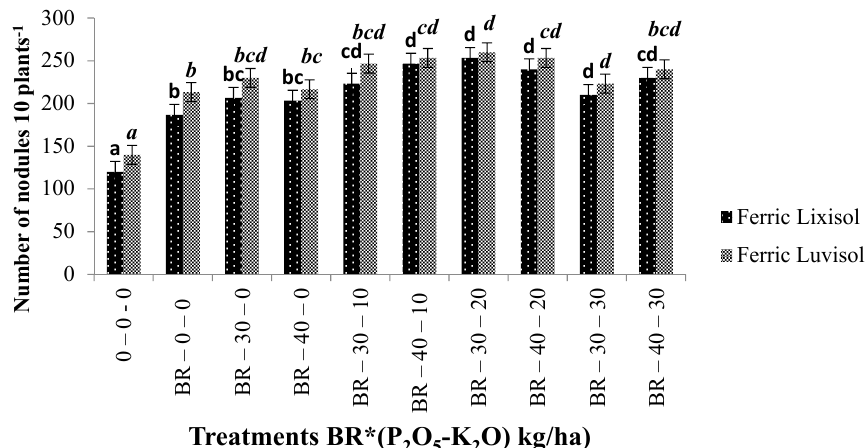
Figure 1. Number of nodules as influenced by inoculant and fertilizer treatments. BR*—Bradyrhizobia inoculant, P 2 O 5 — Phosphorus was supplied by triple superphosphate, K 2 O—potassium was supplied by muriate of potash, error bars denotes the standard error of the means). Bars designated with the same letter(s) are not significantly different ( p < 0.05). Values are means of two years.